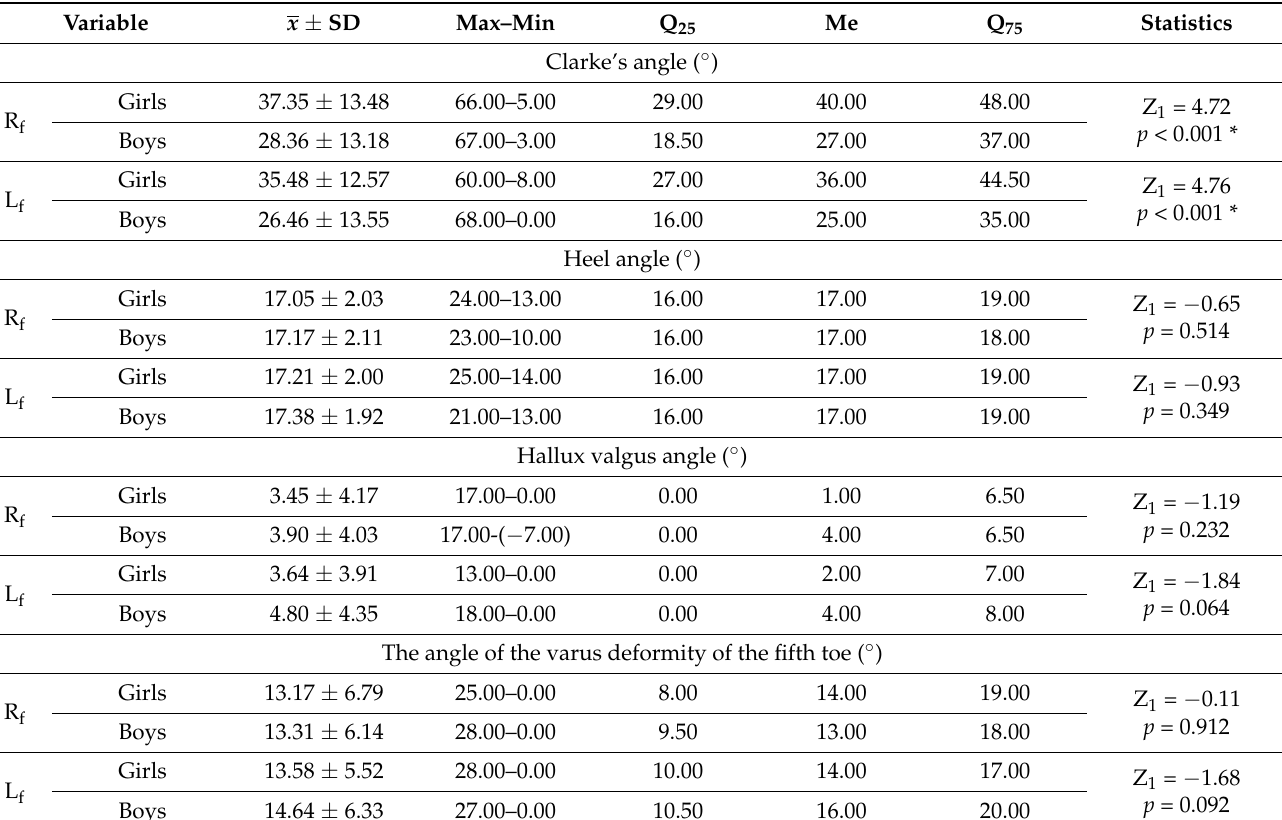
Table 3. Comparison of the features determining the longitudinal and transverse arches as well as the position of the hallux and fifth toe in the examined girls and boys.